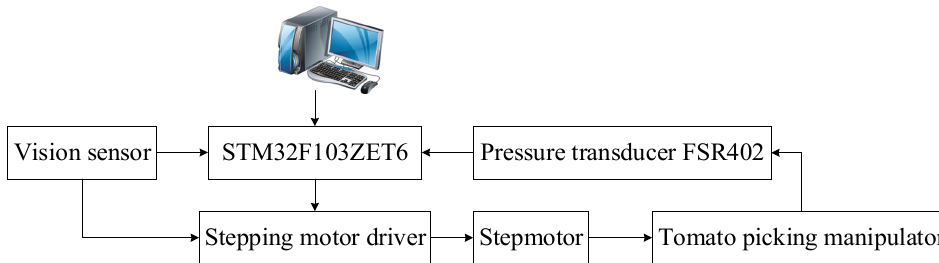
Figure 21. Control architecture of the tomato picking end-e ff ector.